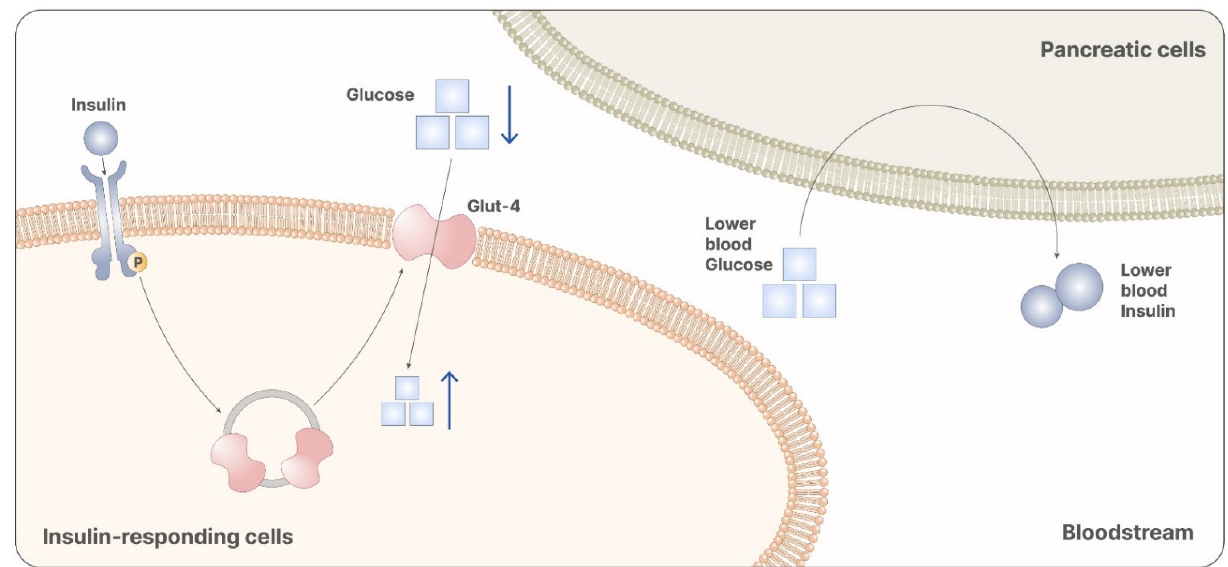
Figure 4. Myo-inositol participates in the signaling cascade of insulin. Particularly, it is involved in the releasing of vesicles containing GLUT-4. GLUT-4 promotes the absorption of glucose from the bloodstream, reducing systemic glycemia. Reduced glycemia is then recognized from pancreatic cells as a stimulus that inhibits insulin release. Therefore, myo-ins administration leads to reduced levels of glucose and insulin, preventing the onset of GDM.